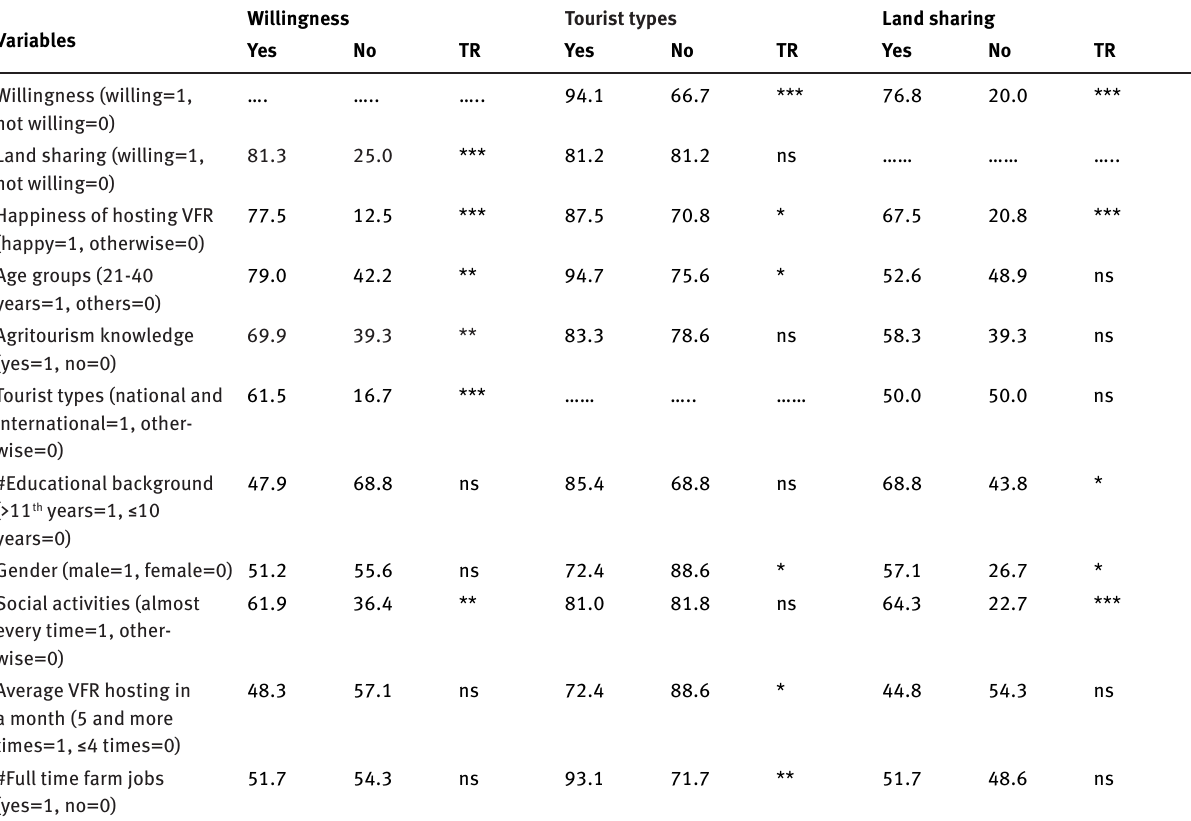
Table 3: Relationship between willingness, tourist types, land sharing, and activities undertaken (Chi-squared/Fisher’s exact test)